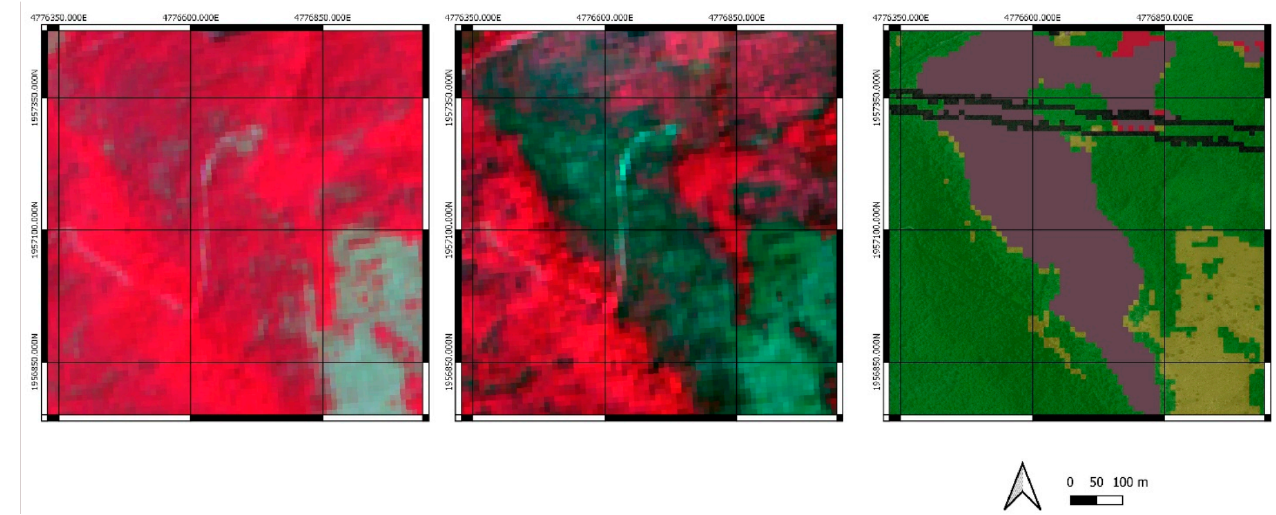
Figure 13. Burnt area, highlighted in grey on the right